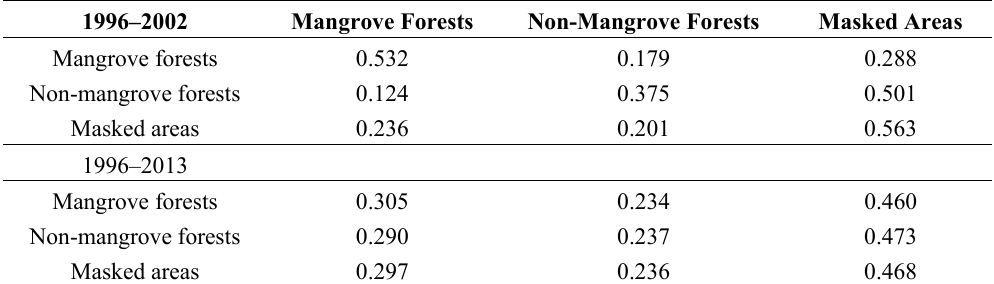
Table 4. Transitional probabilities during 1996–2013.